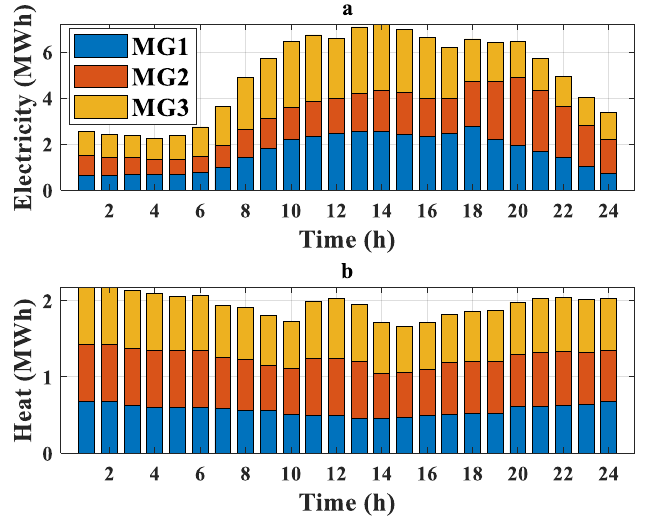
Figure 3. ( a ) Daily electric load profiles of the MGs; ( b ) Daily heat load profiles of the MGs.